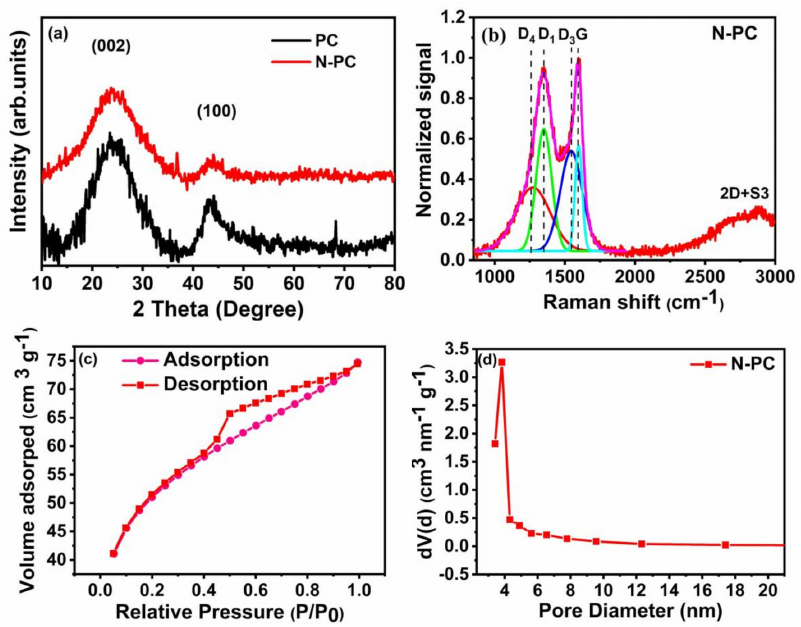
Figure 4. ( a ) XRD pattern and ( b ) Raman spectrum of N-PC with a deconvolution of the D / G spectral region ( c ) nitrogen adsorption / desorption isotherm and ( d ) Barret–Joyner–Halenda model (BJH) pore size distribution plot of